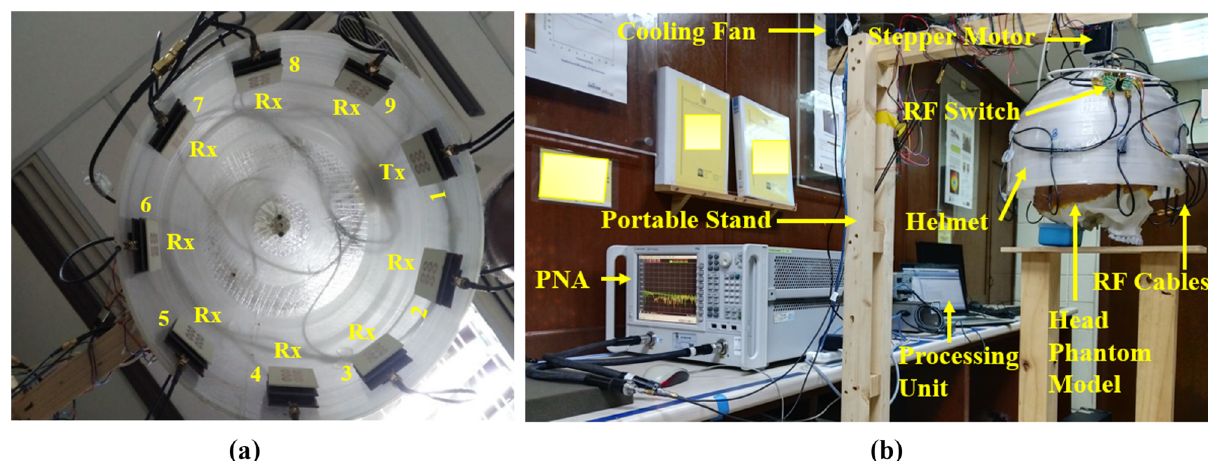
Figure 25. Implemented microwave brain imaging system: ( a ) Nine antenna array setup inside the helmet; ( b ) Overall imaging